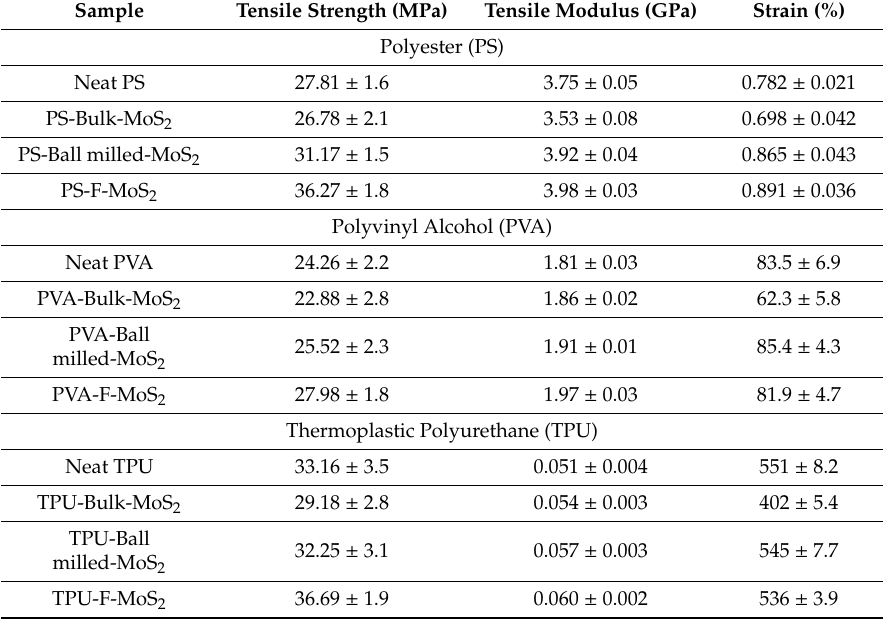
Table 1. Tensile properties of PS nanocomposites, PVA nanocomposites, and TPU nanocomposites including di ff erent types of MoS 2 .